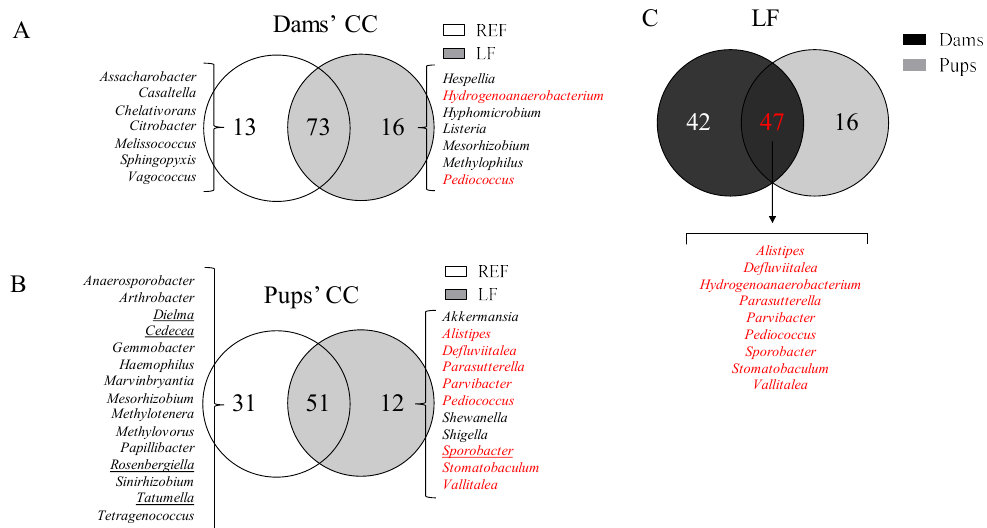
Figure 6. Venn diagrams of the genera present in the cecal content of dams and pups at L14. A bacterial group was considered as present by establishing a cutoff of two animals (out of the three samples analyzed) displaying proportions higher than 0.001%. Venn diagrams are represented for ( A ) dams’ CC, ( B ) pups’ CC and ( C ) the comparison of dams’ and pups’ CC for the LF group. Moreover, the genera highlighted in ( A ) and ( B ) correspond to those genera present in two or three animals in each group, and none of the animals in the other group. The animals underlined correspond to those which are present in 3/3 animals. The animals highlighted in red correspond to those which appear due to the supplementation with LF. Results are expressed as mean ± S.E.M. ( n = 3 animals/group). REF, reference; LF, Lactobacillus fermentum CECT5716; CC, cecal content.